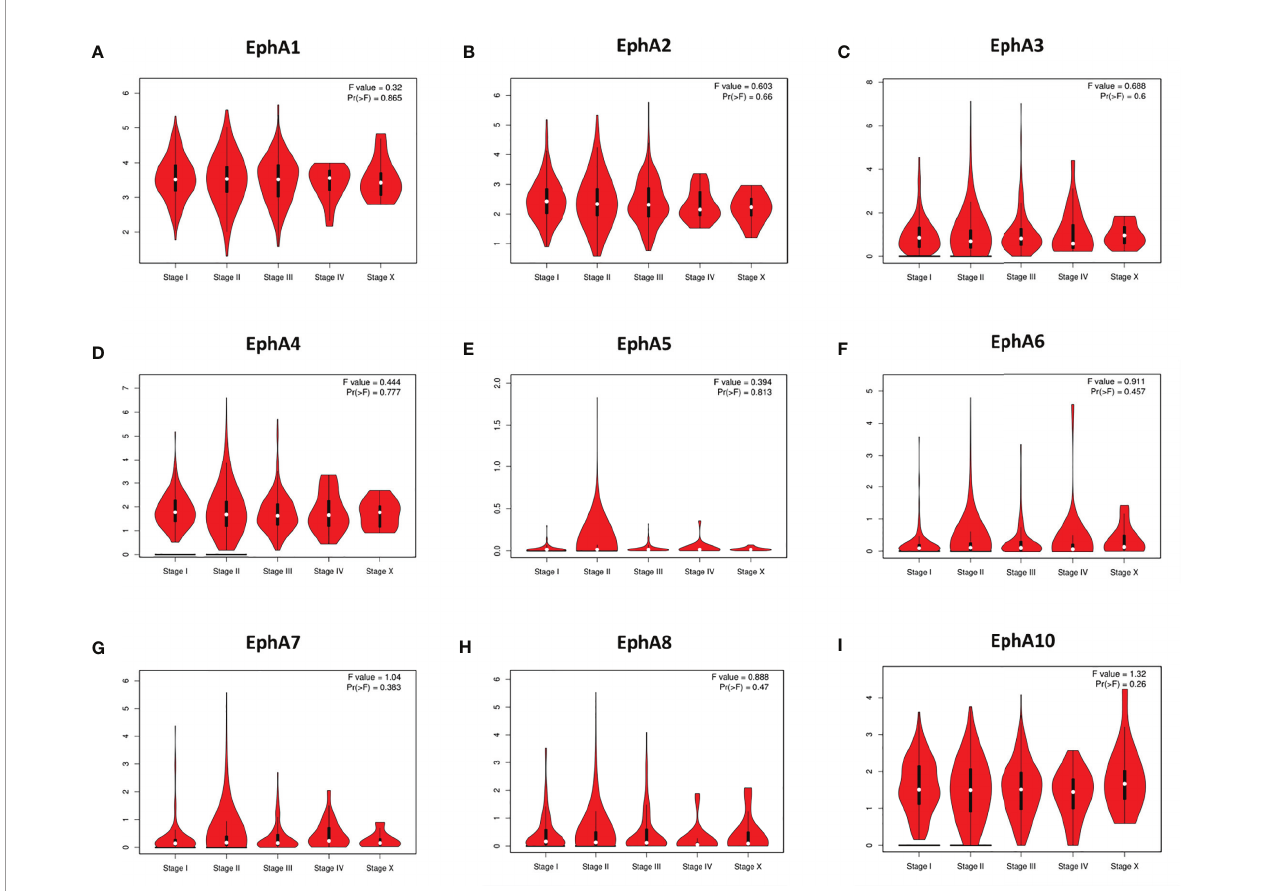
FIGURE 4 | The correlation between EphA family expression and tumor stage of breast cancer patients. The graphs generated from the GEPIA database showed the expression of EphA family genes in different tumor stages of breast cancer. The EphA family genes include (A) EphA1; (B) EphA2; (C) EphA3; (D) EphA4; (E) EphA5; (F) EphA6; (G) EphA7; (H) EphA8; (I)